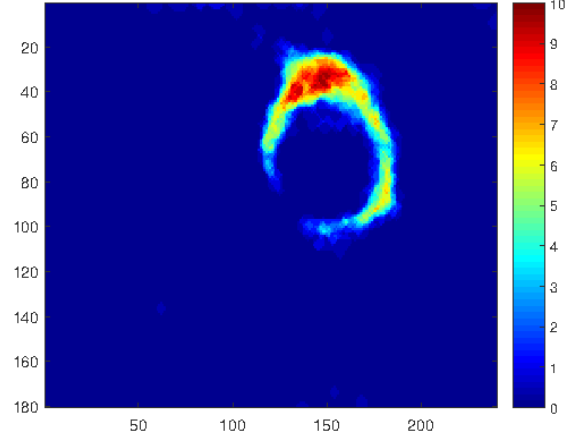
Figure 5. Reconstructed contact area with stress distribution